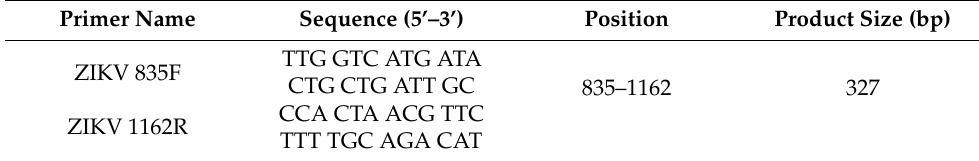
Table 1. PCR primers for amplification of DNA fragments in the PrM and E genes of